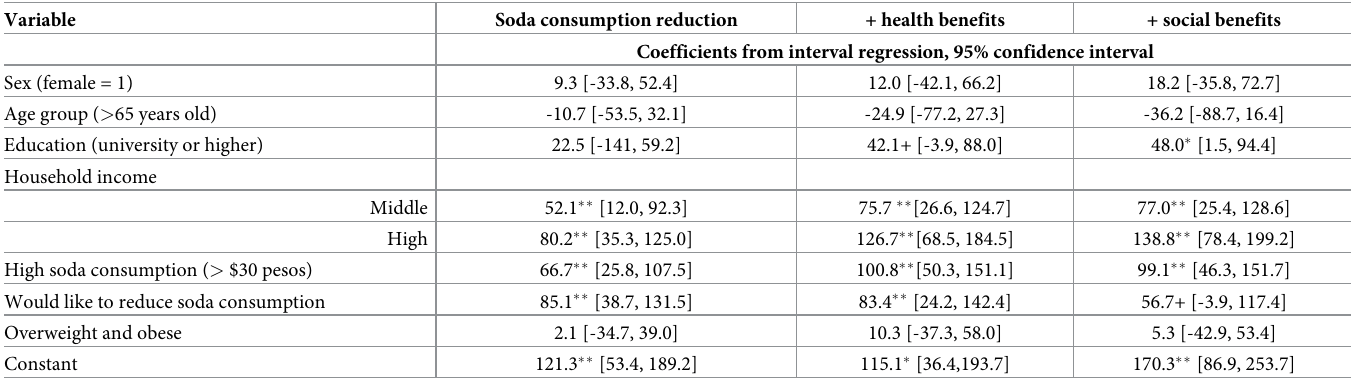
Table 3. Interval regressions for the willingness to pay for an intervention that reduces soda consumption, by scenario. Variable Soda consumption reduction + health benefits + social benefits Coefficients from interval regression, 95% confidence